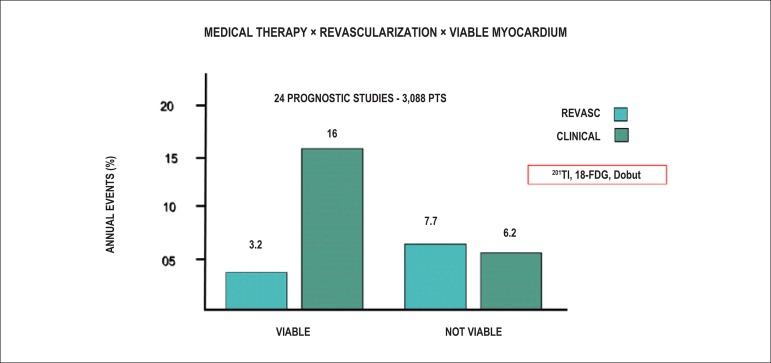
Prognostic studies in patients with severe chronic coronary artery disease and ventricular dysfunction evaluating late survival with revascularization versus medical therapy following viability study via non-invasive testing. 201Tl: thallium-201; FDG-18F: metabolic imaging with fluorodeoxyglucose labeled with fluorine-18; Dobut: doppler echocardiography associated with intravenous injection of dobutamine solution; Revasc: myocardial revascularization surgery; Pts: patients; Viable: viable myocardium. Adapted from Allman KC, et al.287 Note that in the presence of viable myocardium and clinical treatment, the rate of events was > 4 times (16%) higher than in the same situation with surgical treatment via myocardial revascularization (3.2%); however, in the situation of absence of viable myocardium, the comparison between clinical and surgical treatment showed no significant differences in mortality (6.2% vs. 7.7%, respectively).